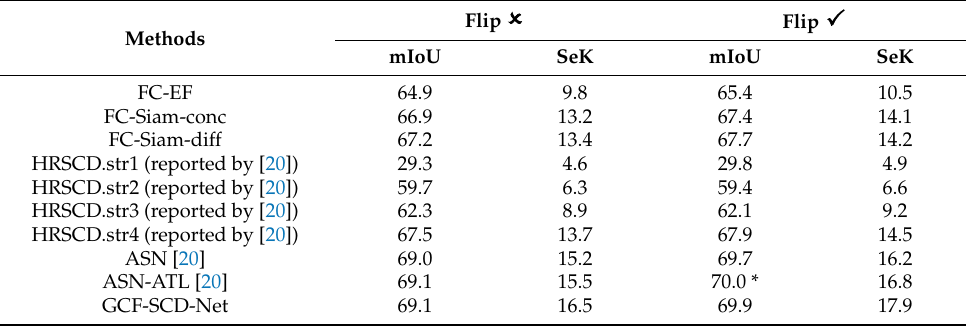
Table 6. Comparison with the state-of-the-art methods (% for all except seK). Methods